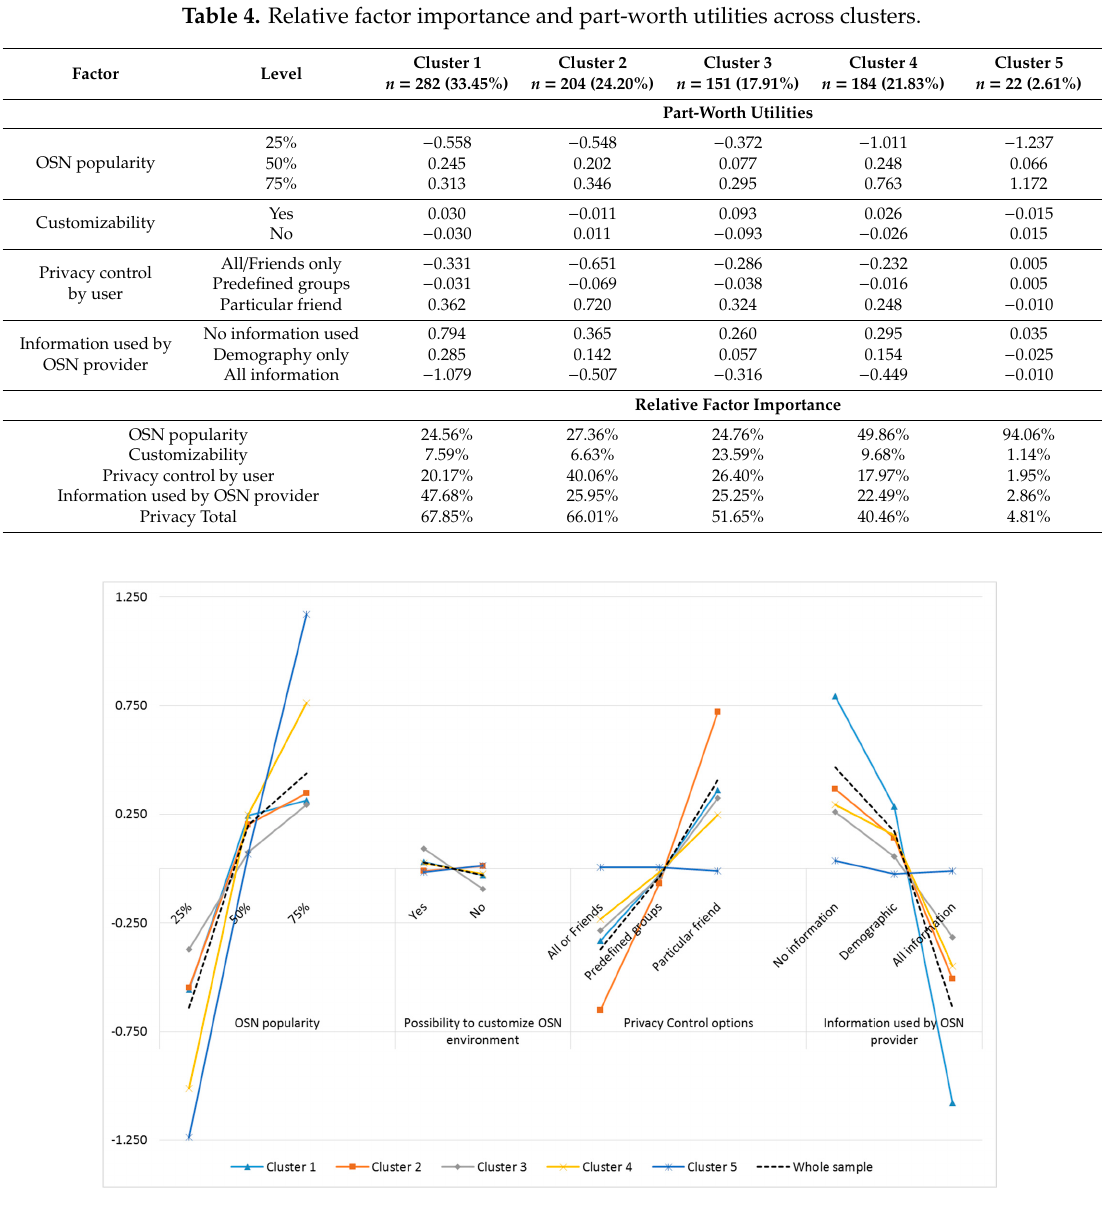
Figure 4. Part-worths functions across clusters.